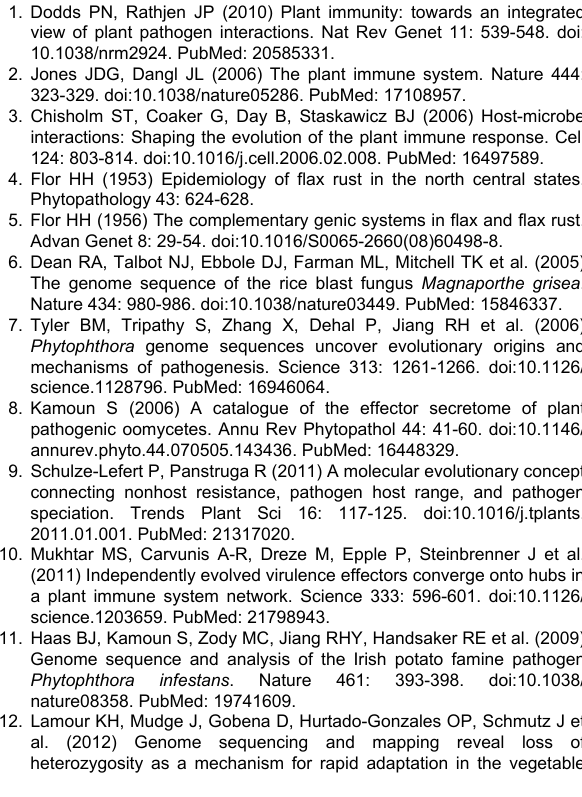
File S3. Nucleotide alignment of subfamily in Figure 2 in Fasta format. (FASTA) Table S1. GenBank accessions by species and locus. (PDF) Table S2. REL rate classes for PrAvh205 orthologs and paralogs for the nonrecombinant region from site 130 to